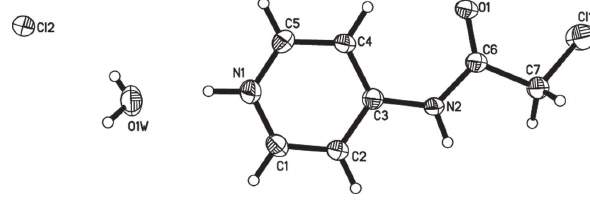
Table 1: Data collection and handling.